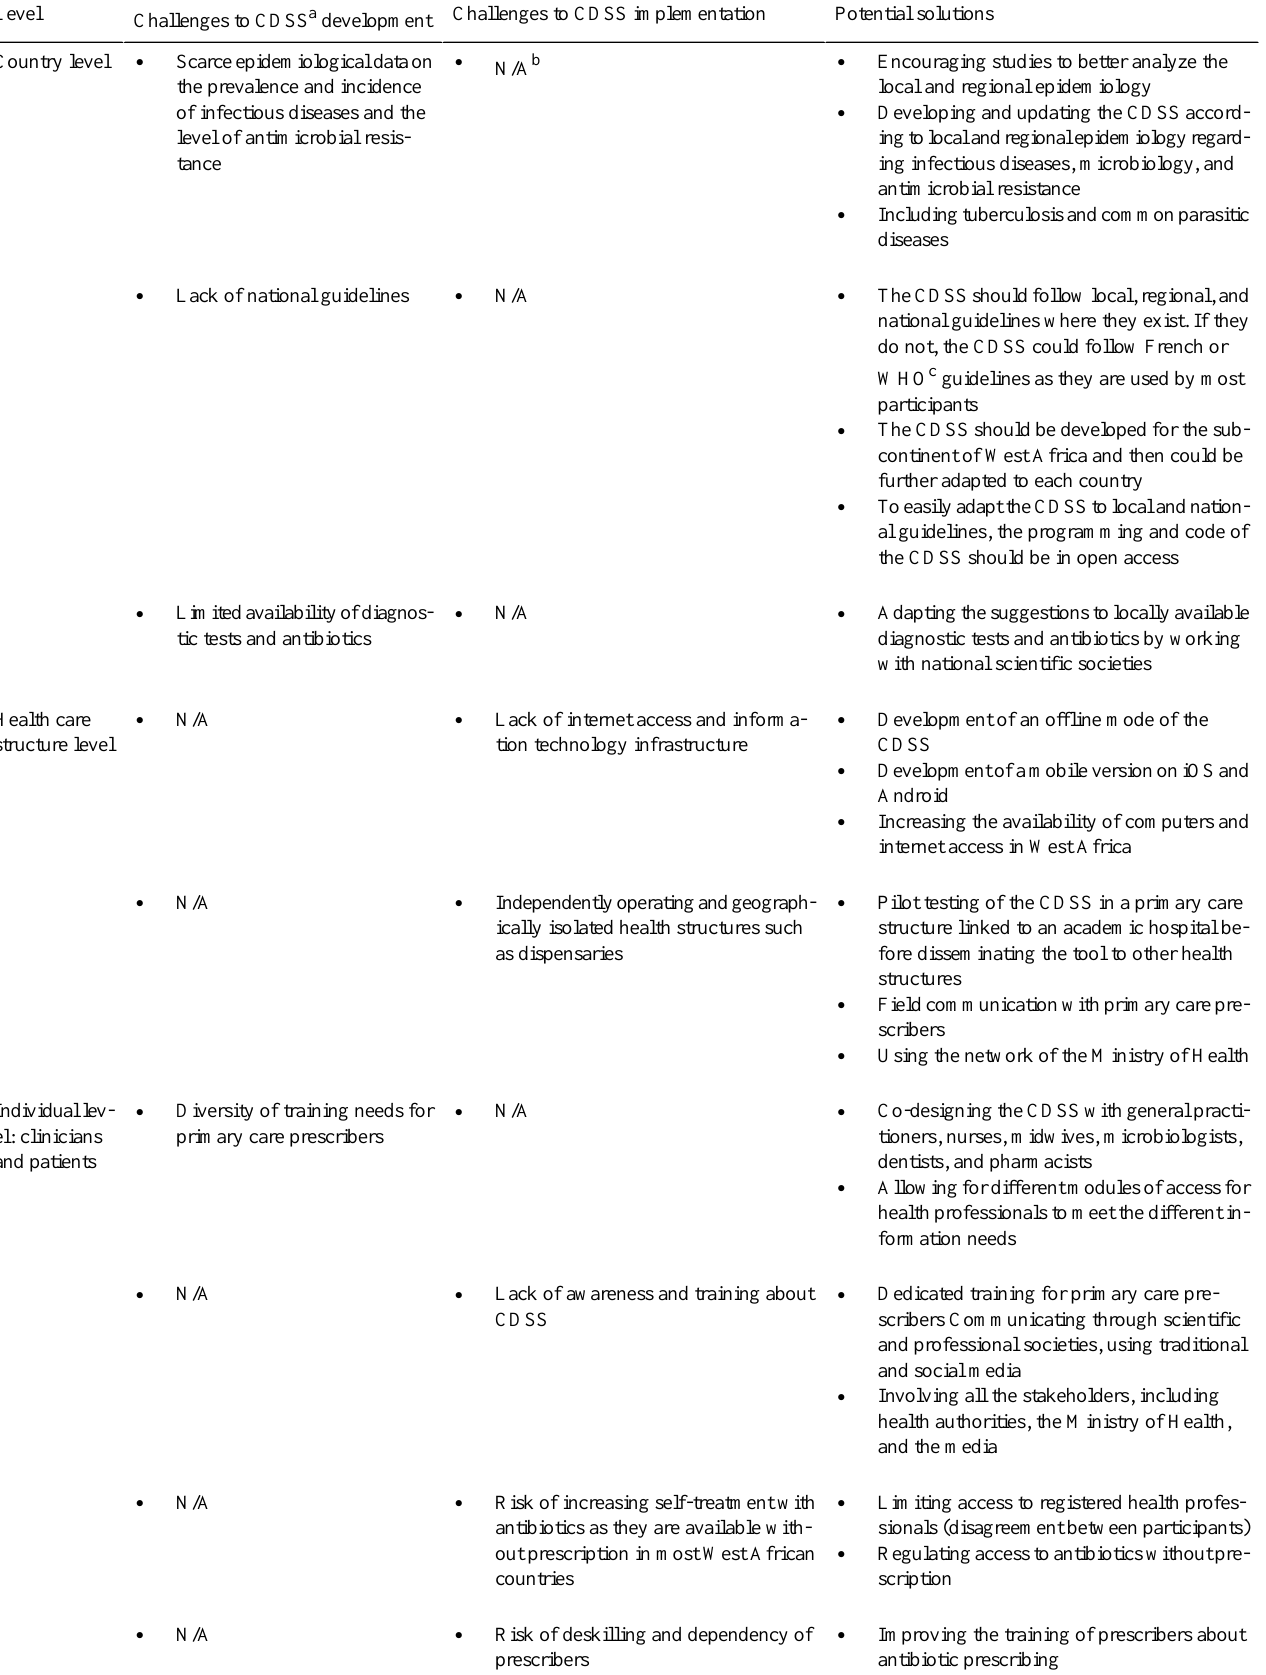
Table 2. Challenges and potential solutions for the development and implementation of a clinical decision support system in the West African